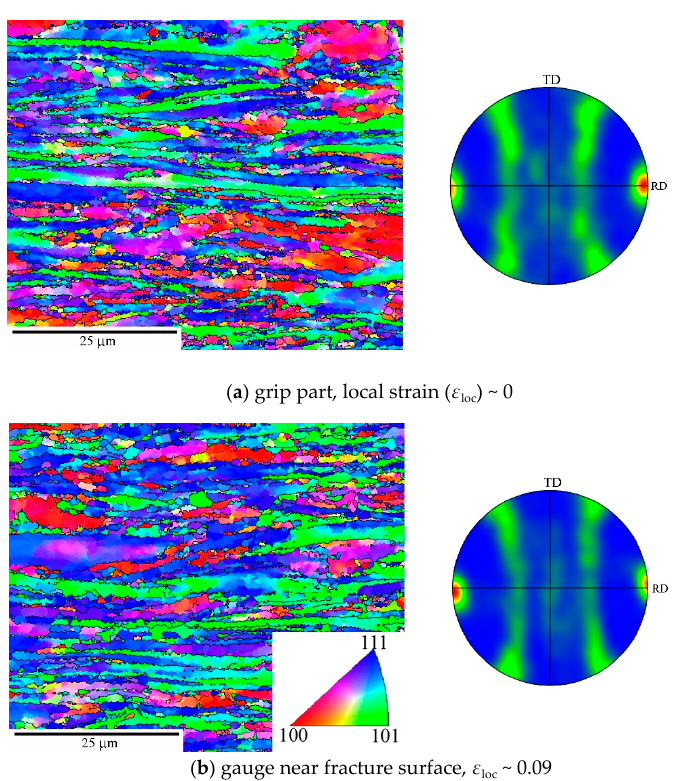
Figure 8. Microstructure and texture of RS after creep at σ 0 = 200 MPa in ( a ) grip part and ( b ) gauge Figure8. MicrostructureandtextureofRSaftercreepat σ 0 = 200MPain( a )grippartand( b )gaugelength length near the fracture. RD directions are parallel with the stress axis. near the fracture. RD directions are parallel with the stress axis.